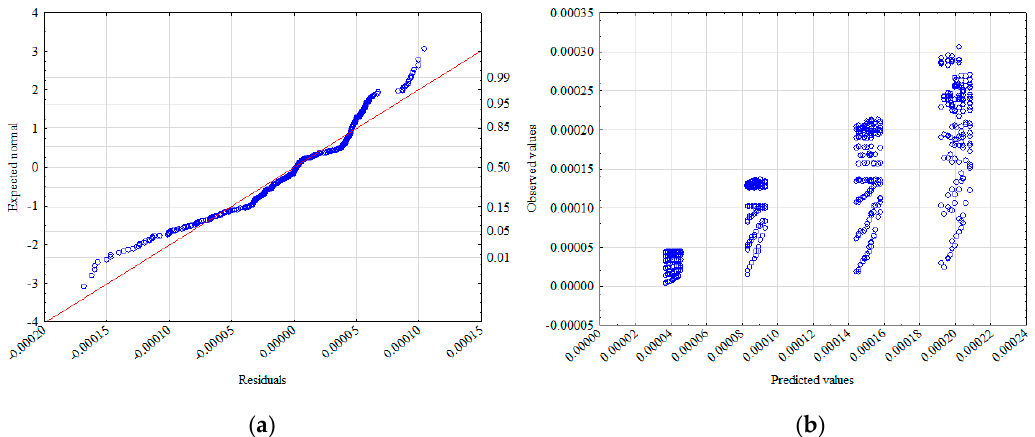
Figure 6. Normality diagram of residuals ( a ) and values observed against predicted ( b ).